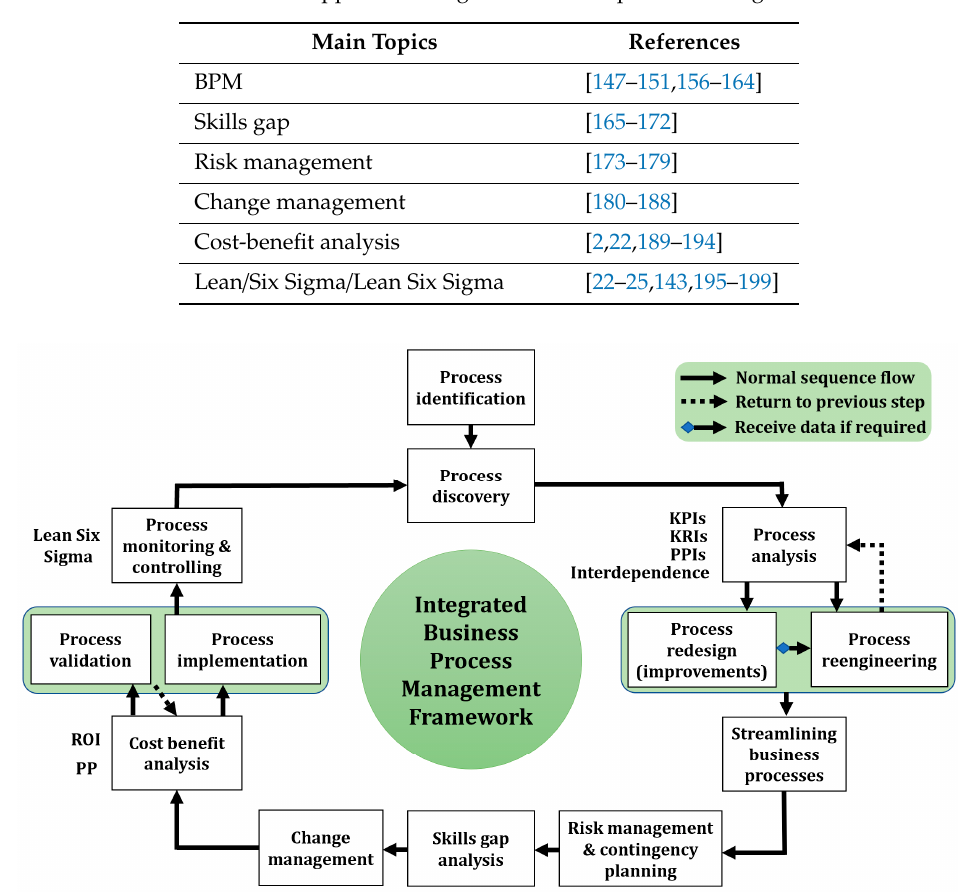
Table 1. Literature used to support the integrated business process management framework.